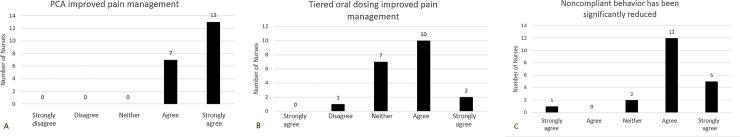
Adult sickle cell unit nurse assessment.Selected adult sickle cell (inpatient) unit registered nurse survey results. Response options are presented in the figures. Numbers are numbers of respondents choosing each response. Questions: (A) “Patient Controlled Anesthesia (PCA) improved pain management.” (B) “Tiered oral dosing improved pain management.” (C) “Noncompliant behavior by patients has been significantly reduced with the implementation of integrated care plans”.